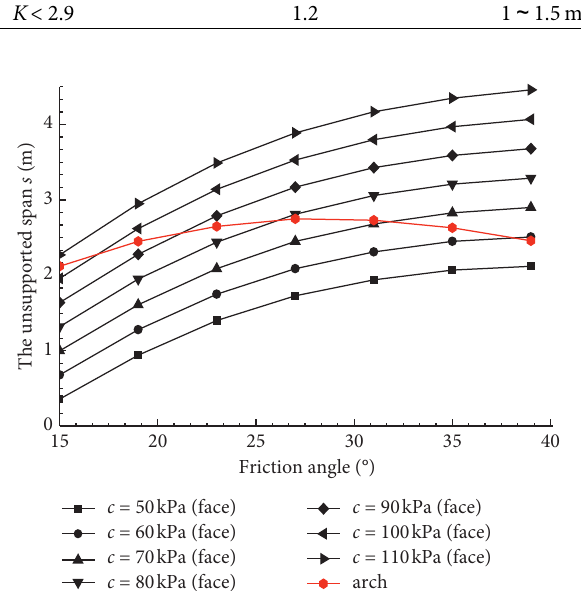
Figure 9: Curves of correlation between s and ϕ